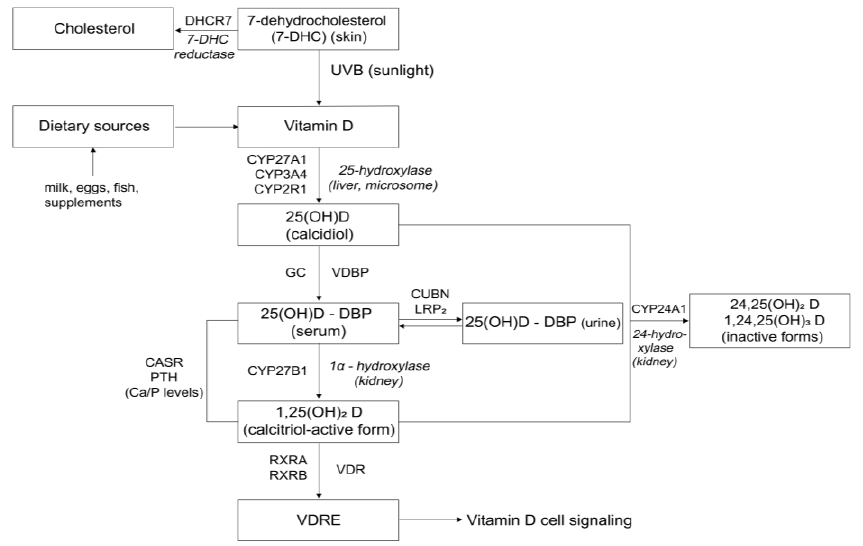
Figure 1. Vitamin D pathway, candidate genes (in bold), and associated enzymes. DHCR7 (7-dehydrocholesterol) gene encodes 7-DHC (7-dehydrocholesterol) reductase enzyme, which converts 7-DHC to cholesterol; CYP2R1 (cytochrome P450 family 2 subfamily R member 1), CYP3A4 (cytochrome P450 family 3 subfamily A member 4), and CYP27A1 (cytochrome P450 family 27 subfamily A member 1) genes encode 25-hydroxylation cytochrome P450 enzymes responsible for converting provitamin D that is absorbed from the diet or synthesized from the action of sunlight on the skin to the circulating form 25(OH)D (25-hydroxyvitamin D); vitamin D is transported bound to vitamin D binding protein (DBP) (encoded by GC gene); LRP2 and CUBN genes encode plasma membrane receptors megalin and cubilin, respectively (involved in re-absorption of 25(OH)D via receptor mediated endocytosis); CYP27B1 encodes the cytochrome p450 enzyme which coverts 1-alpha-hydroxylates 25(OH)D to the active form 1,25(OH) 2 D (1,25-Dihydroxycholecalciferol, Calcitriol); CASR (calcium sensing receptor) binds calcium in extracellular matrix, impacting calcium homeostasis; Ca homeostasis impacts the synthesis of parathyroid hormone (PTH gene-a protein coding gene) which stimulates the synthesis of 1,25(OH) 2 D from 25(OH)D by upregulating renal 1- α -hydroxylase; CYP24A1 encodes a 24-hydroxylase enzyme which catalyzes the degradation of 25(OH)D and 1,25(OH) 2 D in inactive metabolites; VDR encodes the vitamin D receptor, a nuclear receptor which binds 1,25(OH) 2 D and forms a heterodimer with the gene product of RXR — the retinoid X receptor — to mediate the biological actions of vitamin D.